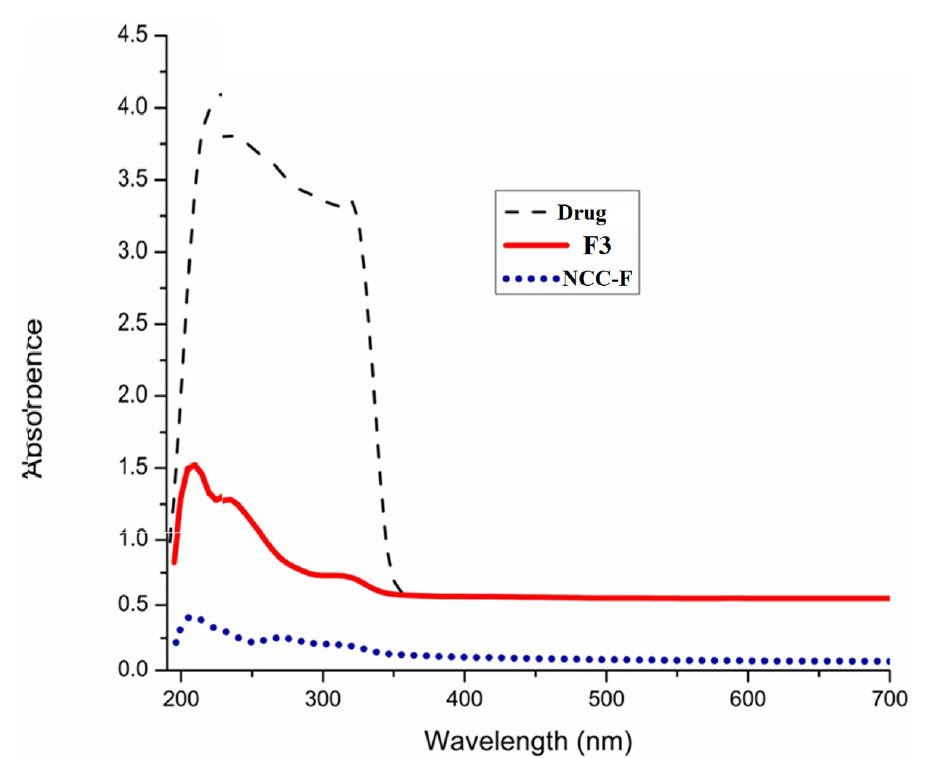
FIGURE 1 - UV absorption spectra of pure drug and oral dispersible film.